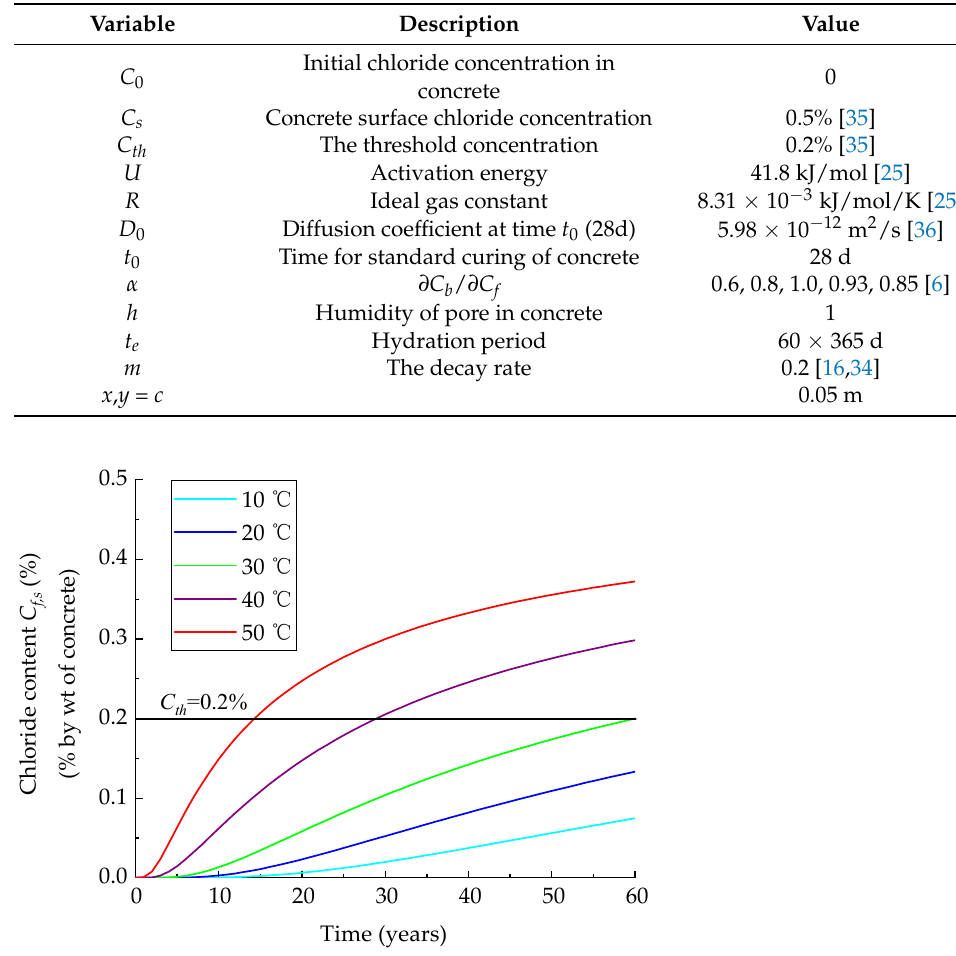
Table 1. Variables in t 1 computation.